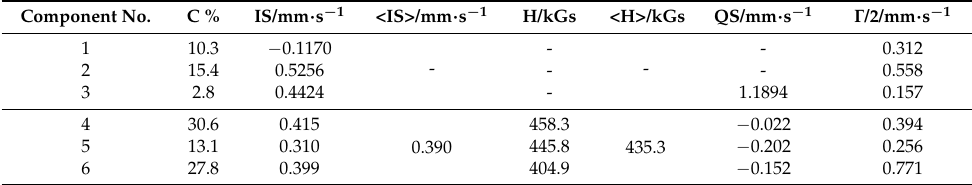
Table 2. Mössbauer spectrum (80 K) components parameters; spectral weight of components, C, isomer shift, IS (relative to 57 Co(Rh) source at 300 K), magnetic hyperfine field H, quadrupole splitting QS, and line width, Γ /2. Mean values of isomer shift, <IS>, and hyperfine field <H>, are provided for magnetic components (4–6) only.